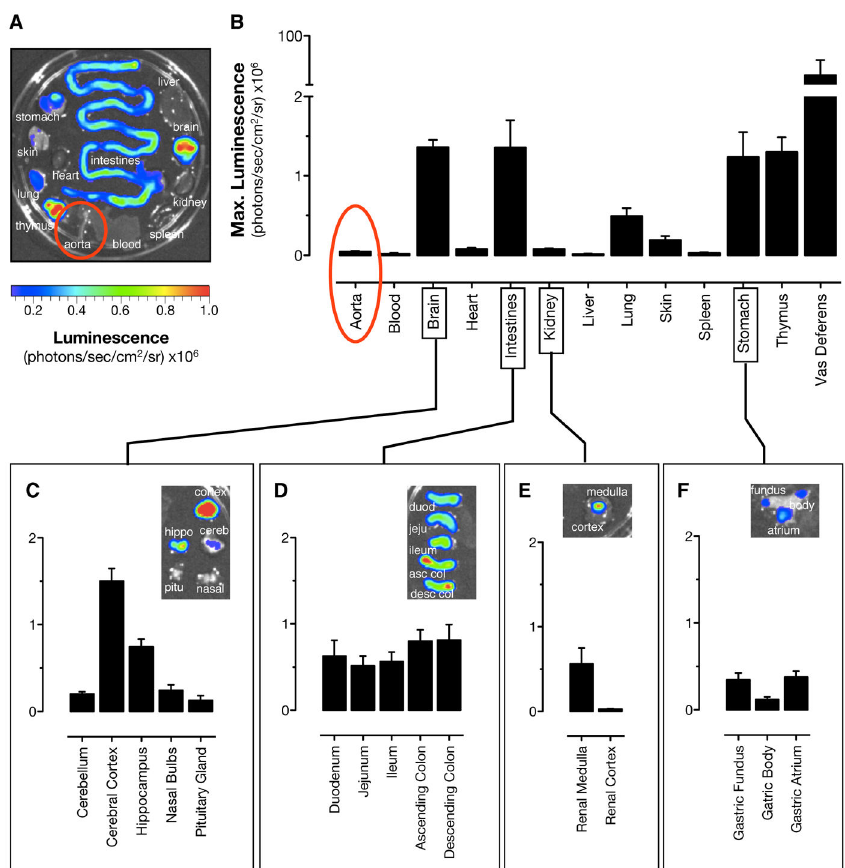
Figure 4. Distribution of luciferin-dependent bioluminescence in tissues from Cox2 fLuc/+ mice. (a) Basal expression from organs of the Cox2 fLuc/+ mice was visualized by bioluminescent imaging of tissues dissected from Cox2 fLuc/+ reporter mice after injection of D-luciferin in vivo (125mg/kg i.p.). (b) Imaging data are expressed as maximum luminescent emission from each tissue. Basal Cox2 gene driven luciferase expression was present in many tissues including the vas deferens, brain, intestine, and thymus but was notably low to absent in the aorta (highlighted with red circles). Sub-division of the (c) brain, (d) intestine, (e) kidney and (f) stomach revealed regional expression patterns within each tissue.